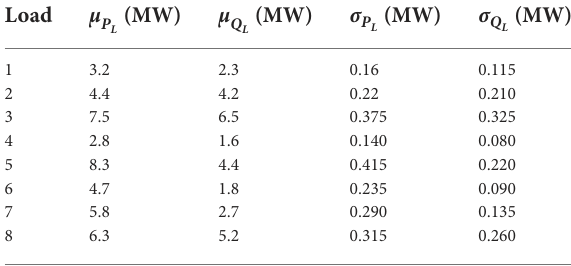
TABLE 1 Parameters of random loads.